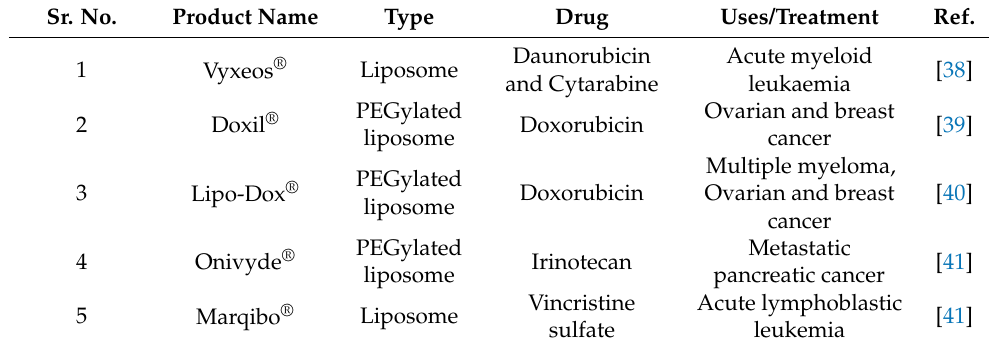
Table 2. Dendrimer for cancer treatment in clinical trials [53]. S. N.